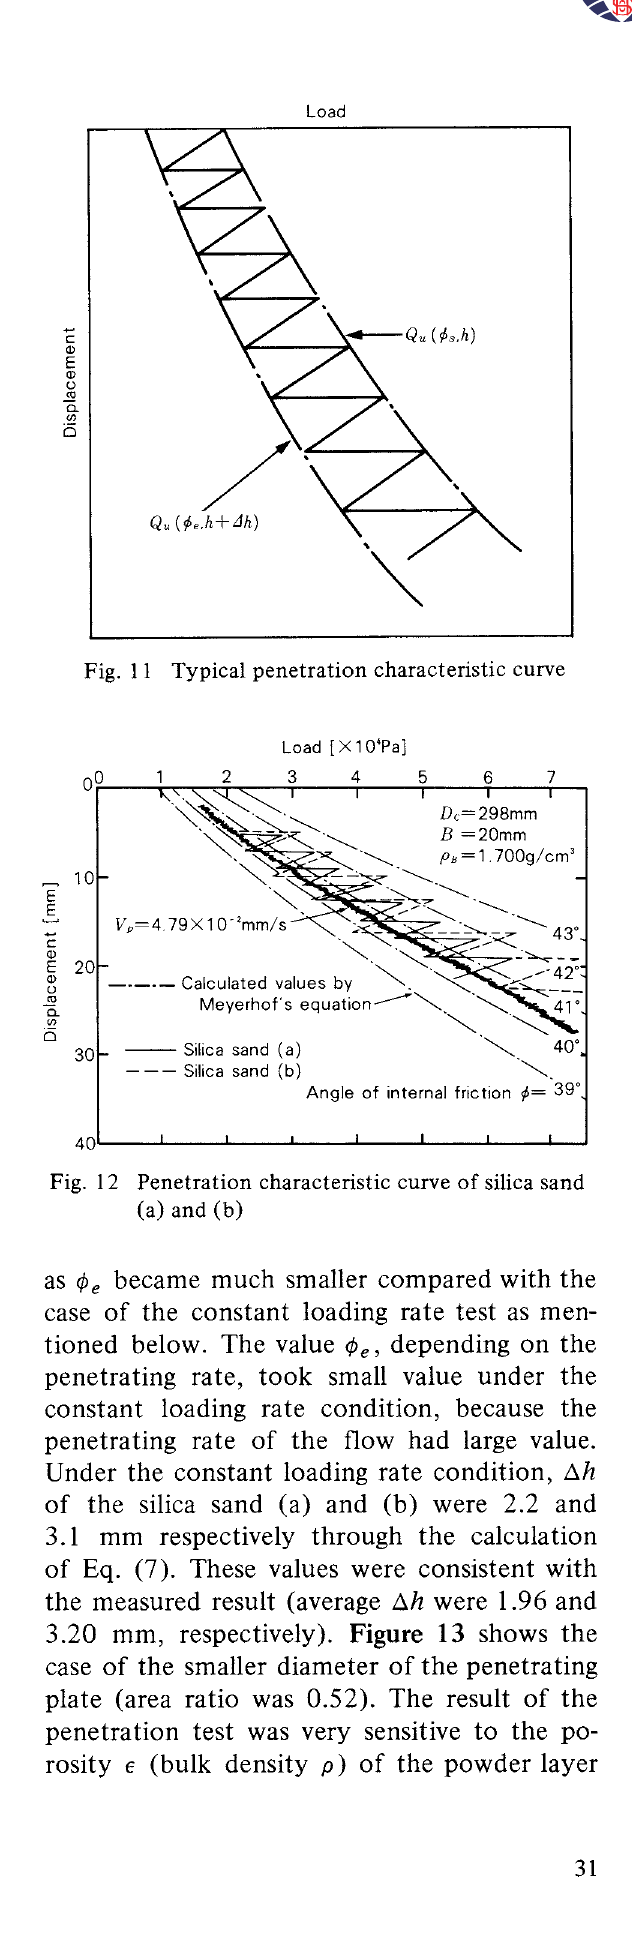
Fig. 11 Typical penetration characteristic curve